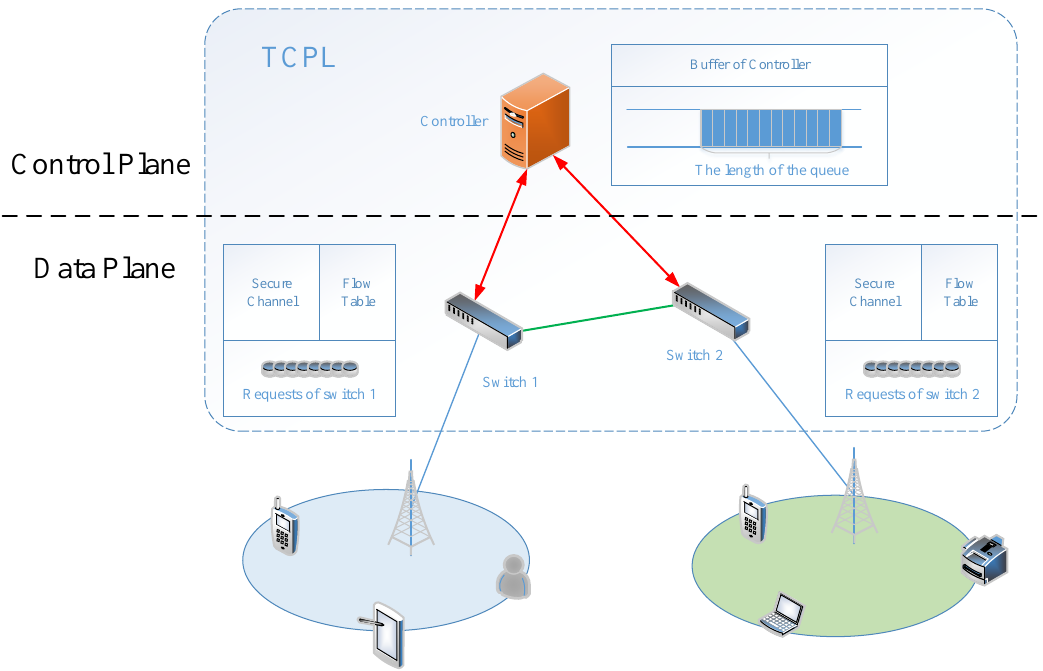
Figure 1. The transmission control system model using TCQG